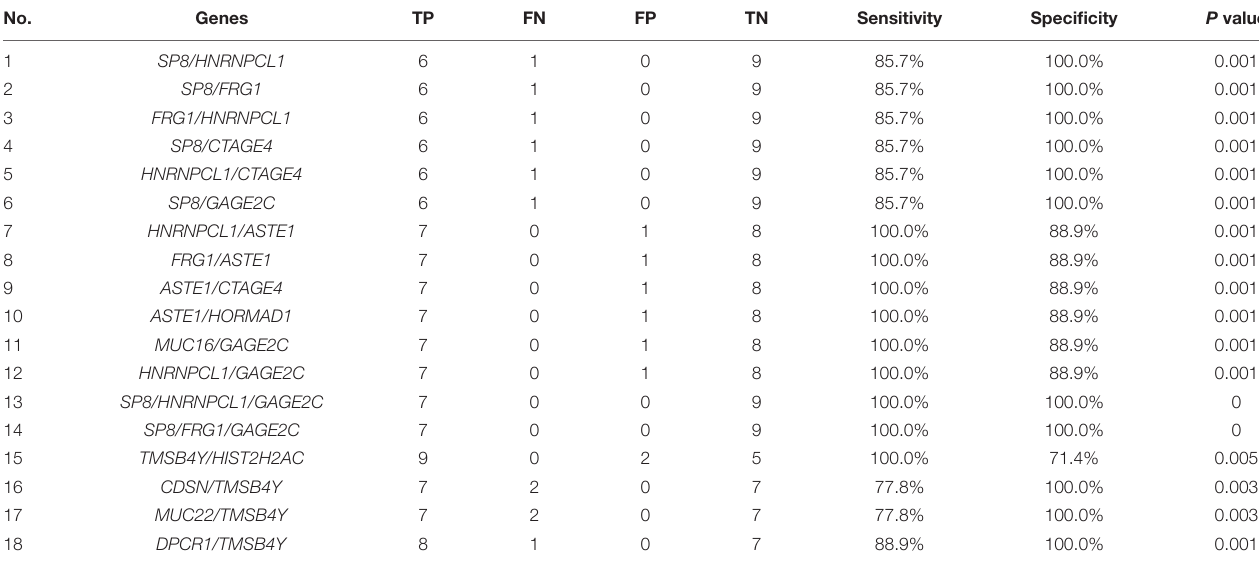
TABLE 3 | Classifiers of several genes in combination to assess dicycloplatin resistance (Nos. 1–14) and dicycloplatin susceptibility (Nos. 15–18).